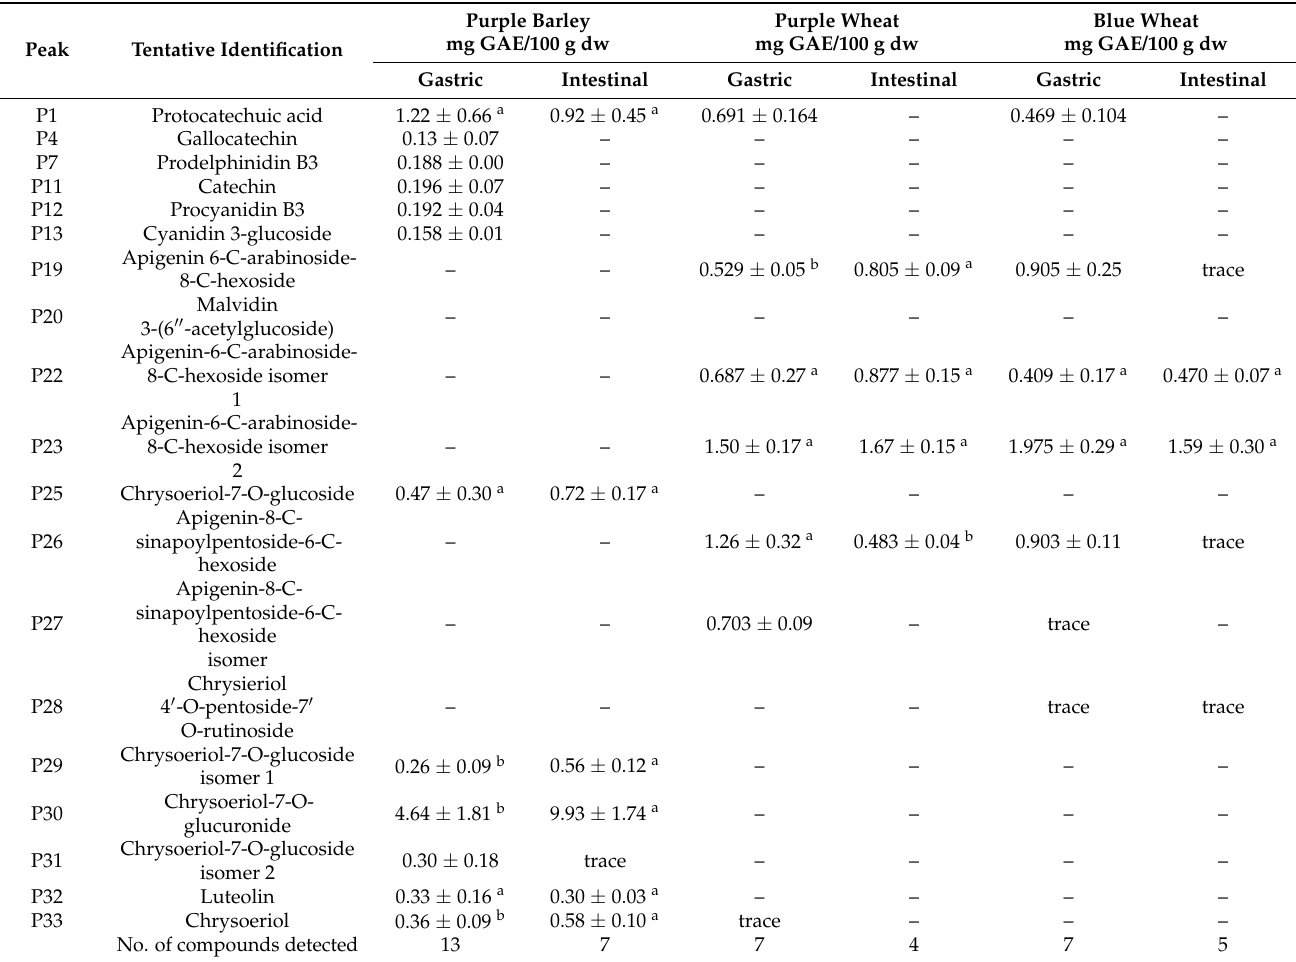
Table 3. Quantification of polyphenols measured at 280 nm using UHPLC from post digestion at gastric and intestinal